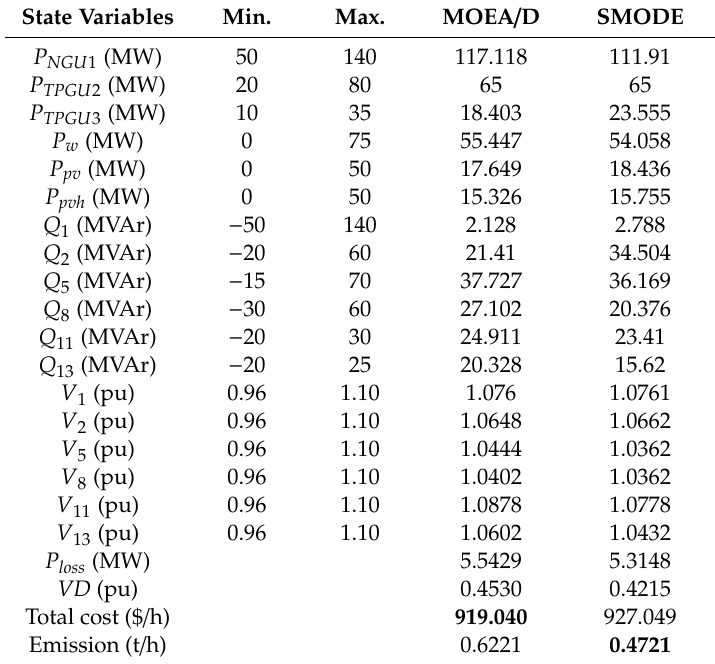
Table 6. Detailed numerical results of the optimization techniques for Scenario